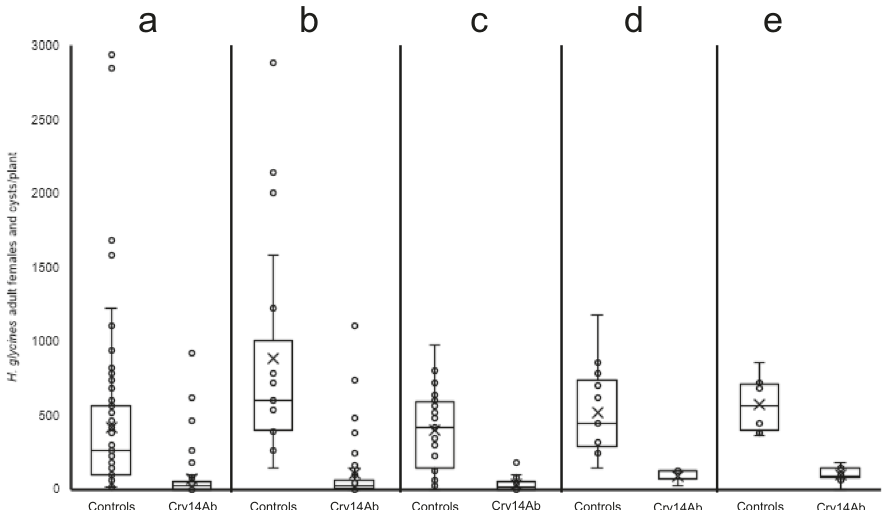
Fig. 9 The ability of Cry14Ab to reduce Heterodera glycines reproduction in the greenhouse was assessed in the PI 88788-derived soybean variety Jack. Untransformed plants and negative control events transformed only with a selection vector (Controls) were compared to multiple Cry14Ab- expressing events (Cry14Ab). Soybean plants were grown in sand in 4-inch clay pots in a greenhouse and infested at 2 weeks with H. glycines . Box plots indicate median (middle line), average ( x ), 25th to 75th percentile (box) and 5th and 95th percentile (whiskers) as well as all data points. a T1 soybean plants (Controls: n = 82 plants; Cry14Ab: n = 57 plants) were infested with H. glycines line OP50, and after 30 days adult females and cysts were counted, giving FI = 14.7 ( P < 0.0001, t = 4.8, df = 137). b T1 soybean plants (Controls: n = 19 plants; Cry14Ab: n = 36 plants) were infested with H. glycines line OP50, and after 60 days adult females and cysts were counted, giving FI = 12.3 ( P < 0.0001, t = 5.1, df = 56). c T2 soybean plants (Controls n = 41 plants; Cry14Ab: n = 47 plants) were infested with H. glycines line OP50, and after 60 days adult females and cysts were counted, giving FI = 8.4 ( P < 0.0001, t = 10.0, df = 82). d T1 soybean plants (Controls: n = 15 plants Cry14Ab: n = 3 plants) were infested with HG type 2.5.7 H. glycines , and after 30 days adult females and cysts were counted, giving FI = 16.8 ( P = 0.03, t = 2.3, df = 16). e T2 soybean plants (Controls; n = 6 plants; Cry14Ab: n = 8 plants) were infested with HG type 2.5.7 H. glycines , and after 60 days adult females and cysts were counted, giving FI = 17.0 ( P < 0.0001, t = 6.2, df = 12). Source data are provided as a Source Data fi